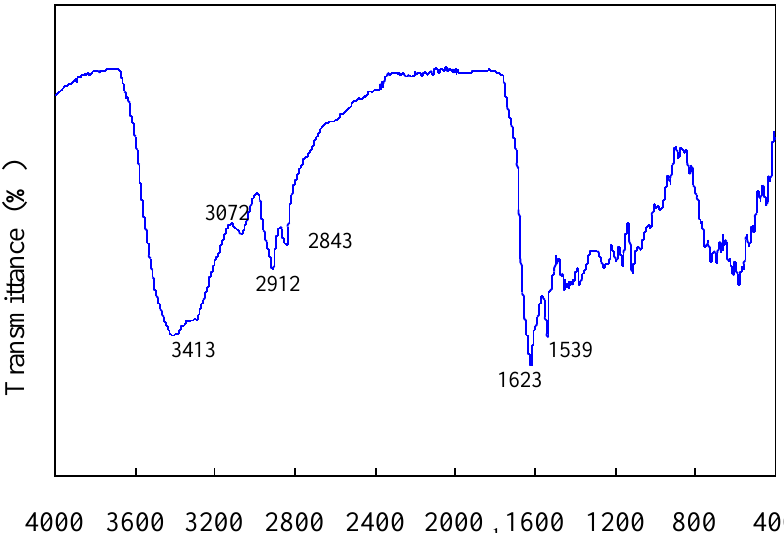
Figure 1. FTIR analysis spectra determined for nylon-6 tennis string waste samples.